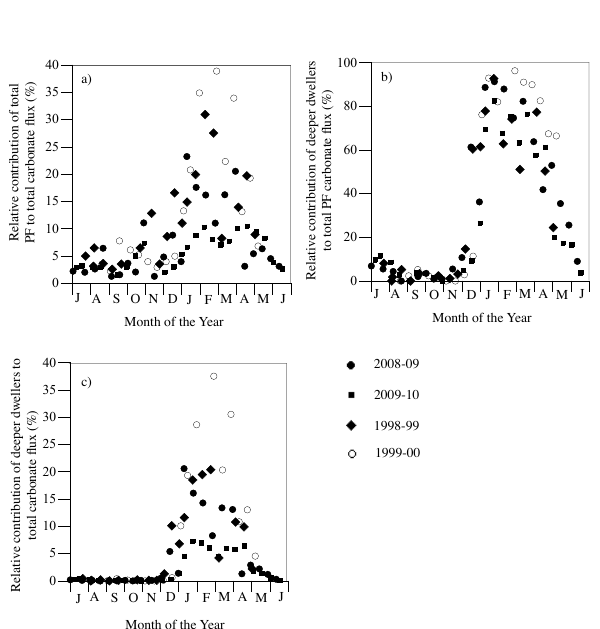
Figure 9. (a) The relative contribution of total PF to total carbon- ate flux (b) The relative contribution of deeper-dwelling planktonic foraminifera ( G. hirsuta, G. truncatulinoides, G. crassaformis, G. inflata ) to the total planktonic foraminiferal carbonate flux (c) The relative contribution of total deeper dwellers ( G. hirsuta, G. trun- catulinoides, G. crassaformis, G. inflata ) to the total carbonate